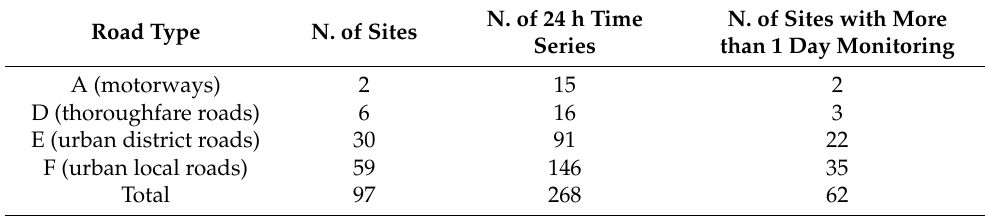
Table 1. Distribution of the 97 sites considered in the study according to the Italian road functional classification. Road Type N. of Sites